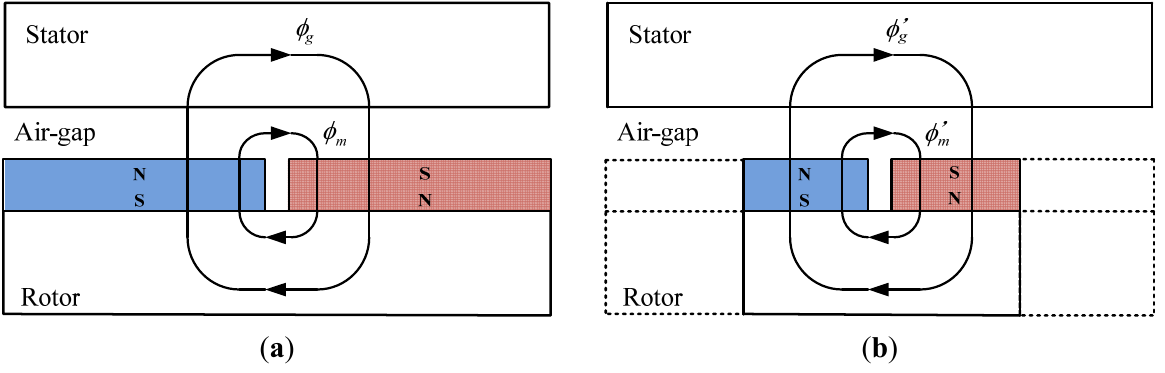
Figure 1. Schematic diagram of PMSM: ( a ) magnetic flux path, ( b ) definition of half magnetic pole